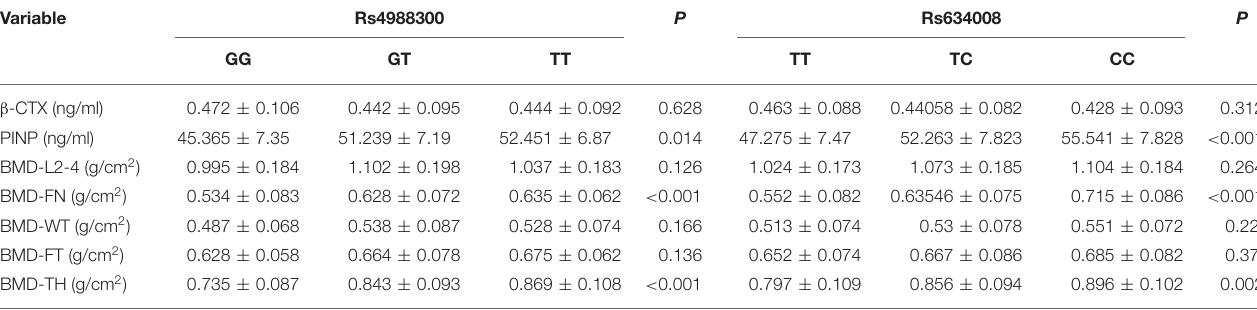
TABLE 6 | Relationships of SNPs genotyped with BTMs and BMDs in female with osteoporotic fracture. Variable